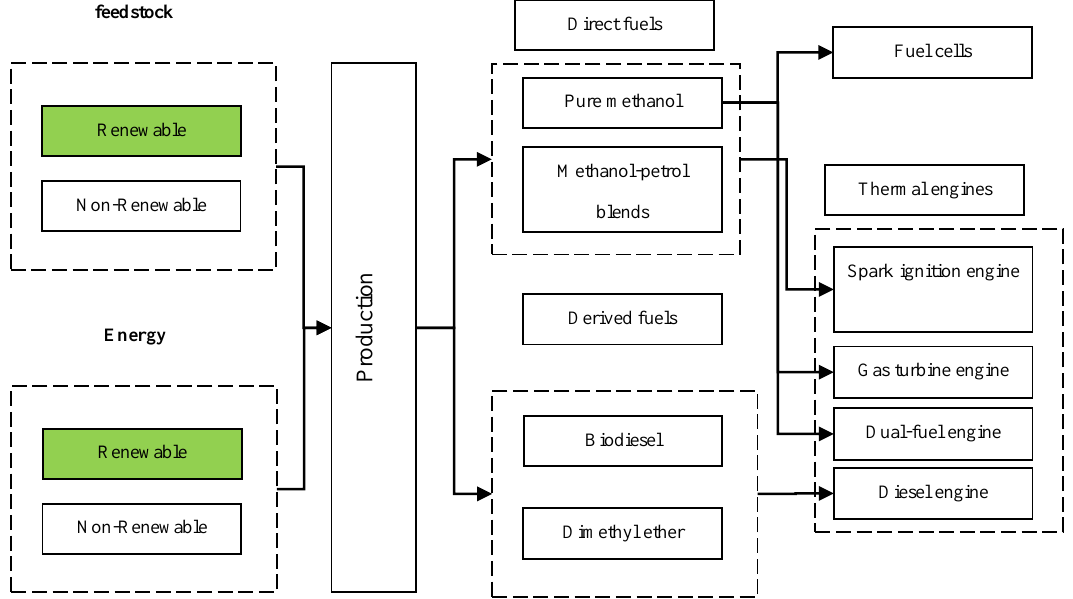
Figure 12. Methanol-based fuel production and utilization.